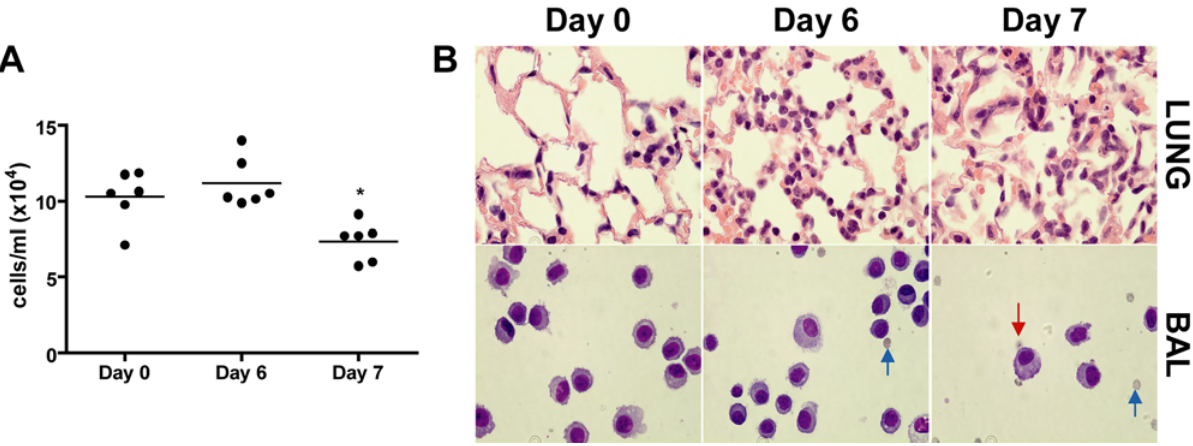
Figure 3. Cellular content of BALF and histopathological analysis of lung tissue from PbA-infected C57BL/6 mice. To further characterize lung injury in this model, both lung histopathology and BAL cell counts were examined during PbA infection. A. Alveolar cell counts (derived from BAL, n=6 per group/experiment) do not differ significantly from baseline, and no neutrophil infiltration was observed. However, there is a significant decrease in BALF cellular content at Day 7 compared to Day 6 (Kruskal-Wallis test with Dunn’s multiple comparison test; * p , 0.05). B. H&E stained sections of lung tissue show increased inflammatory cells in the lungs of PbA infected mice, although cells appear to accumulate in the interstitium and do not accumulate in the alveolar spaces (top panel: lung). Giemsa-stained cytospin preparations of BALF cells (bottom panel: BAL) show few differences in alveolar cell types overall. Individual animals showed increased red blood cell numbers in the BALF at day 6 and 7 (blue arrows), some of which were parasitized erythrocytes (red arrow). Therefore, interstitial inflammation, without transmigration of inflammatory cells into the alveolar spaces, occurs in PbA-induced ALI.